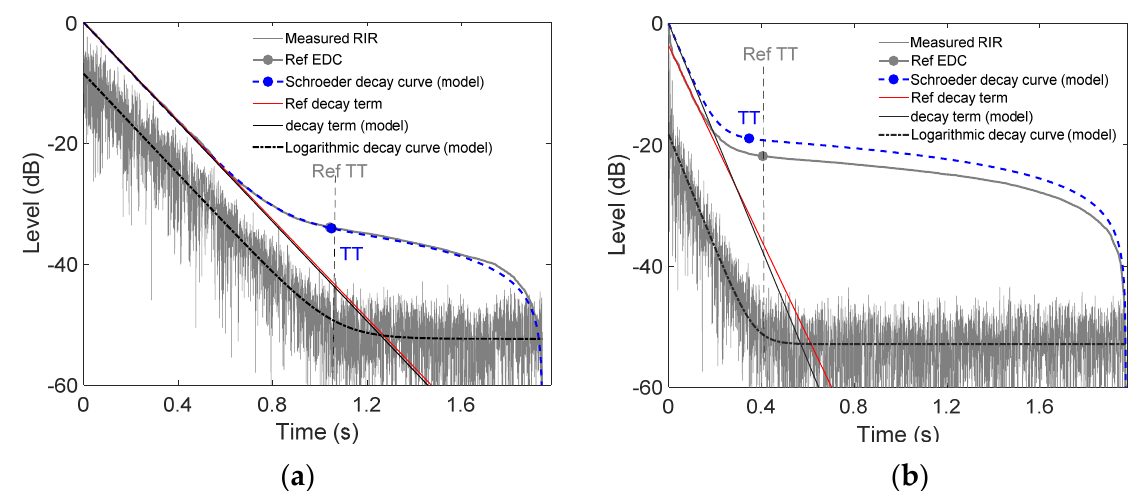
Figure 2. Logarithmic decay curves (black dotted line) and Schroeder decay curve (blue dotted line) generated from the model (Equation (1)) after applying LS optimization together with the comparison between the reference TT and TT of the model and decay term: ( a ) Decay curves of the measured RIR (room C) with exponential decay; ( b ) Decay curves of the measured RIR (room B) with non-exponential decay.